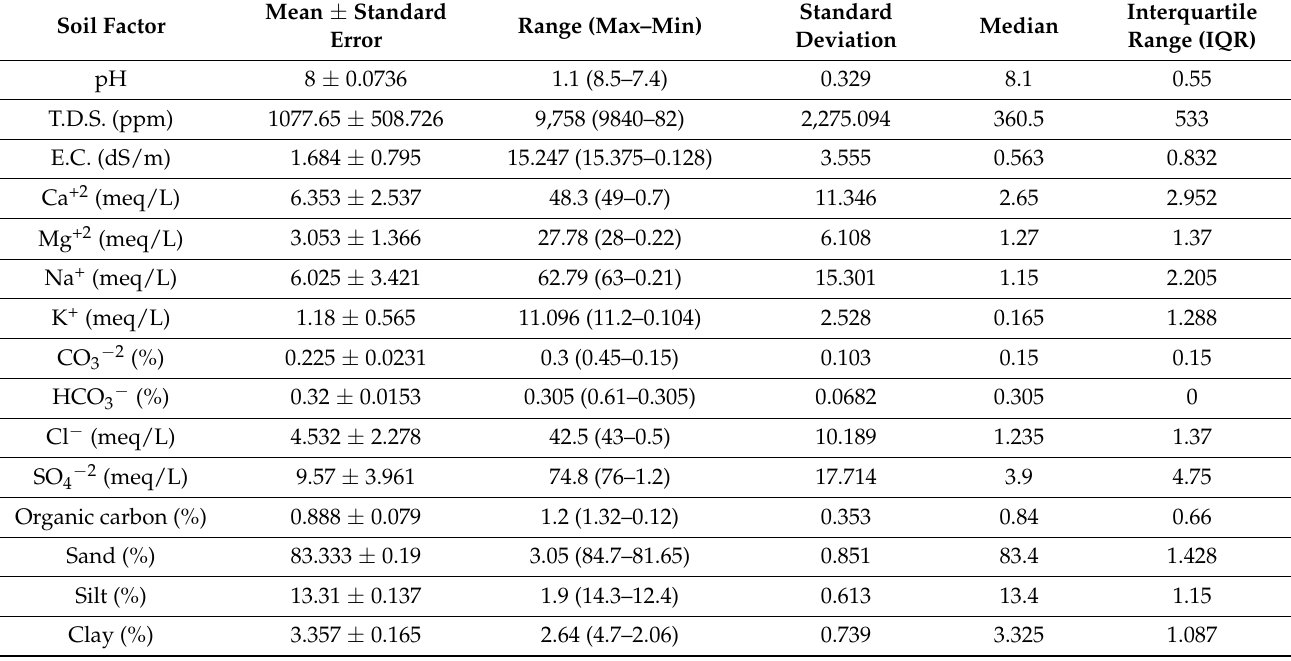
Table 3. Descriptive statistical analysis of soil